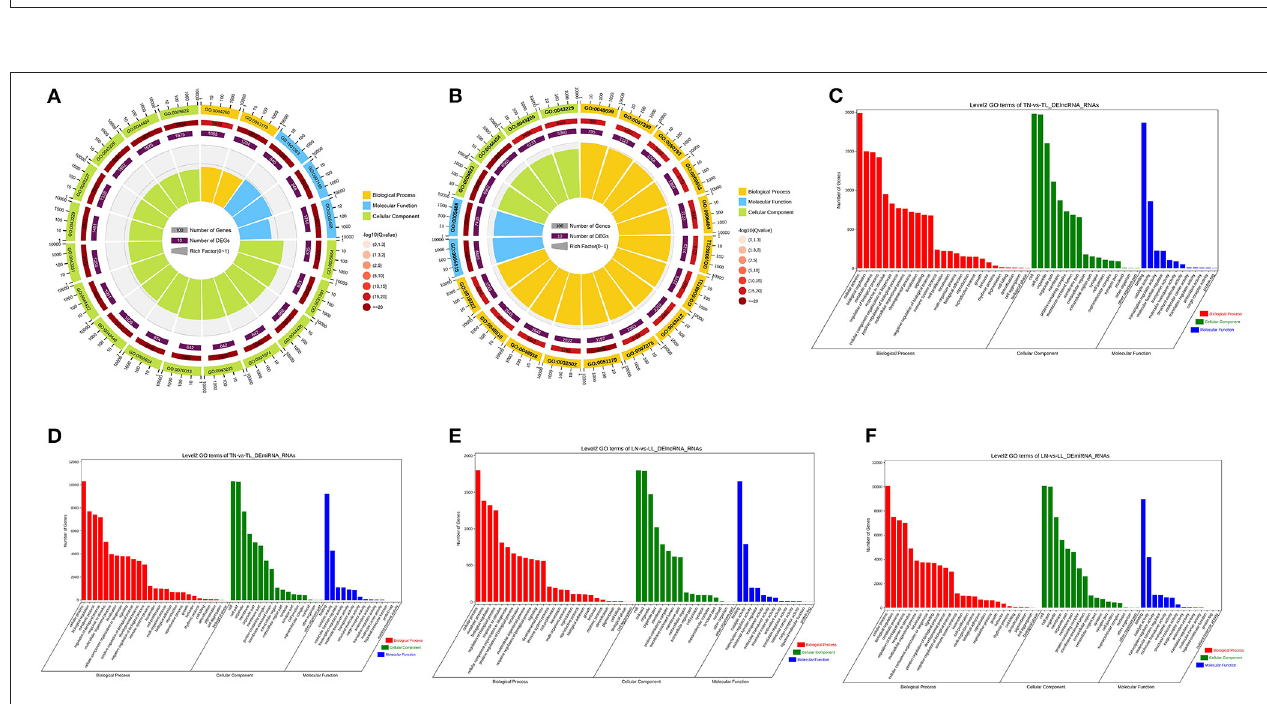
FIGURE 3 | GO functional annotation. Common target mRNAs of DElncRNAs (A) and DEmiRNAs (B) between the normoxic (TN and LN) and hypoxic (TL and LL) groups. Target mRNAs of DElncRNAs (C) and DEmiRNAs (D) between the TN and TL groups. Target mRNAs of DElncRNAs (E) and DEmiRNA (F) of Landrace pigs between the LN and LL